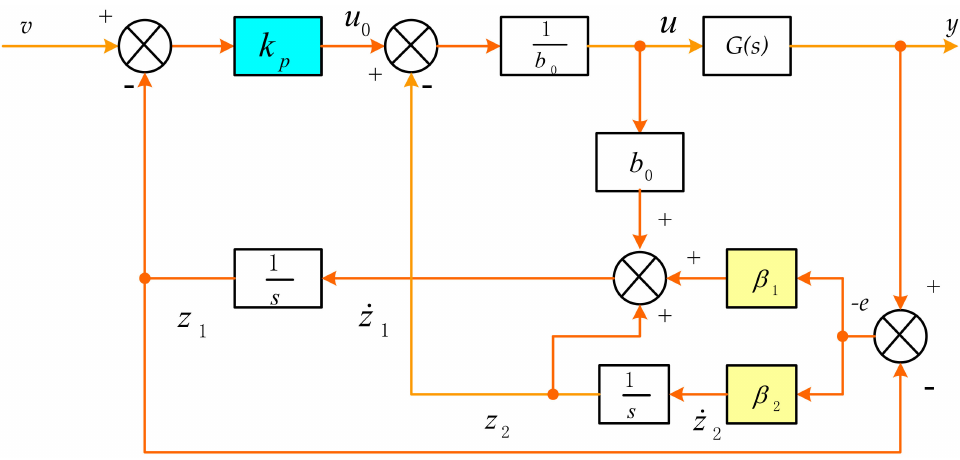
Figure 5. First-order linear active disturbance rejection control (LADRC) control block